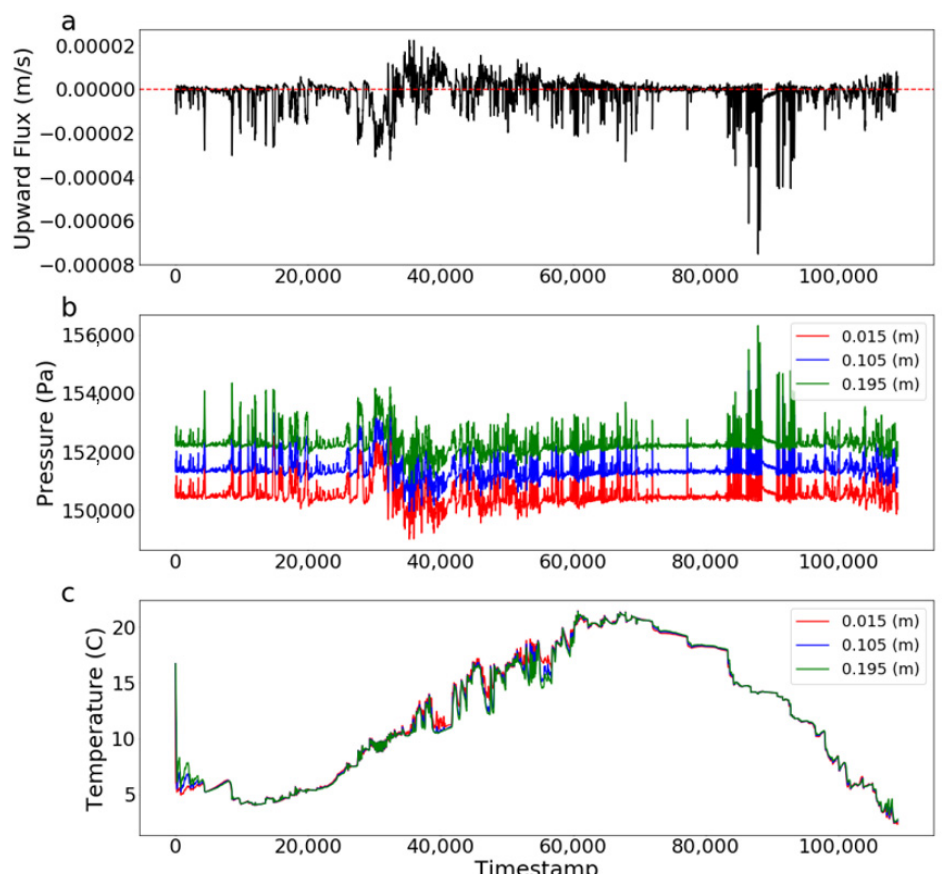
Figure 2. Time series of ( a ) surface/ground water exchange flux across the streambed, ( b ) pressure at three depths, and ( c ) temperature at three depths.